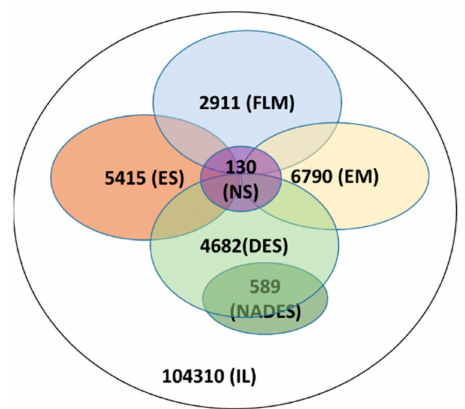
Figure 2. Schematic representation of interests in the specified fields by the overall number of published papers (updated September 2020) focusing on ionic liquids (ILs), functional liquid media (FLM), eutectic solvents (ESs), eutectic mixtures (EMs), and neoteric solvents